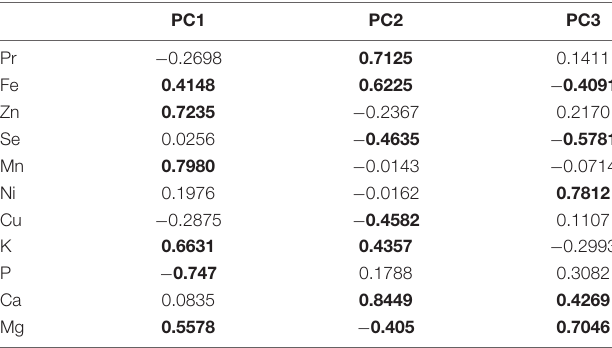
TABLE 5 | Correlations and contribution of protein content and macronutrient and micronutrient concentrations to the first three principal components of the principal component analysis (PCAs).